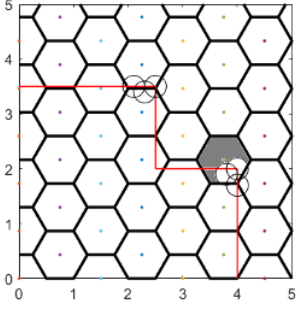
Fig. 4. The simulation